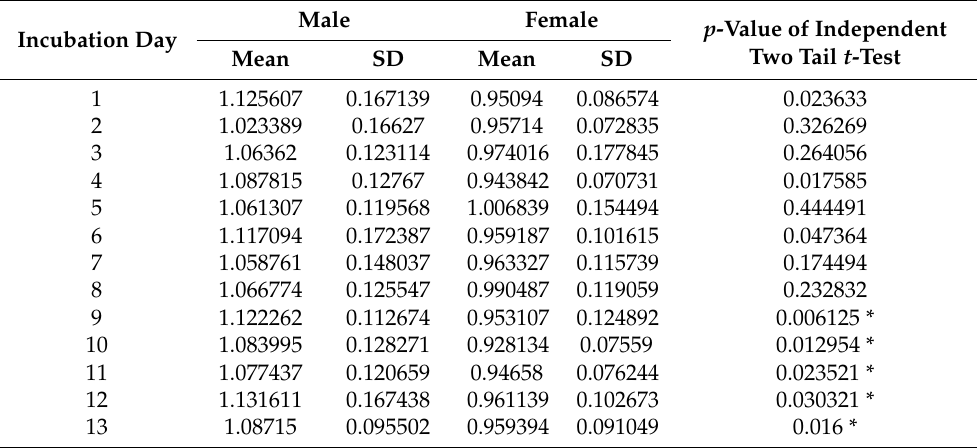
Table 3. Mean impedance ratio value of male and female egg throughout the 13 days of incubation measured at the frequency of 376